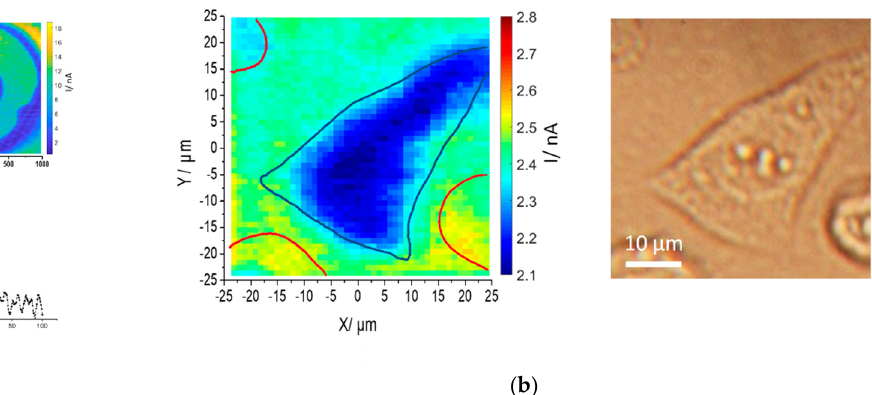
Figure 6. ( a ) AC photocurrent images of a PMMA dot on InGaN measured at 0.6V; ( b ) AC photocurrent image of a mesenchymal stem cell on InGaN surface [40].